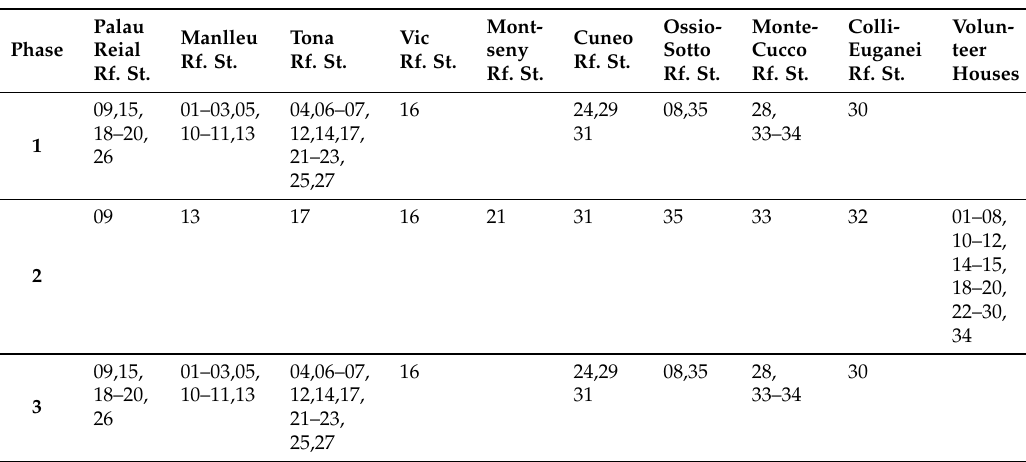
Table 2. Captor nodes history: Palau Real, Manlleu, Tona, Vic and Montseny are reference stations in Spain; Cuneo, Ossio Soto, Monte Cucco and Colli Euganei are reference stations in Italy. Captor nodes are labeled from 17001 to 17035 (abbreviated as 01 to 35). Node 17032, placed in Italy in Colli